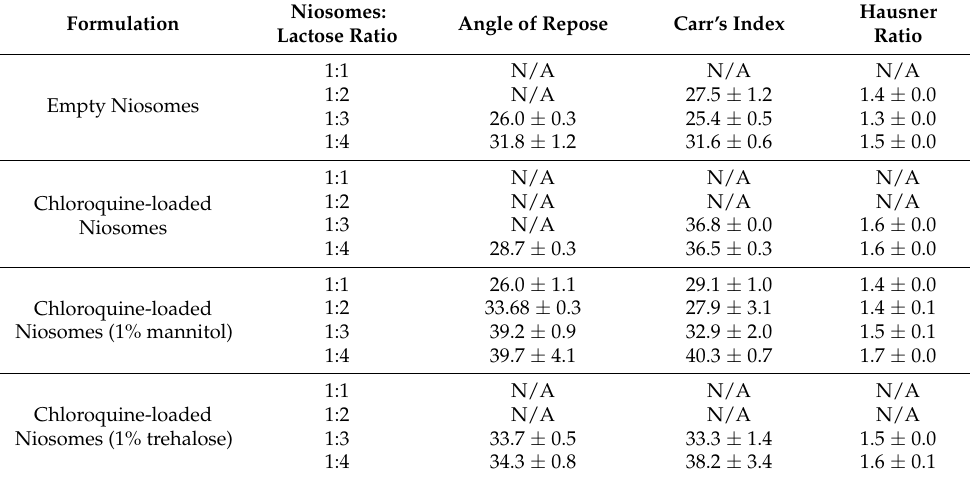
Table 2. Micromeritic properties of lyophilized empty niosomes and chloroquine-loaded niosomes mixed at various weight ratios with lactose (1:1–1:4), in terms of angle of repose, Carr’s index, and Hausner ratio. The effect of the presence of cryoprotectants, namely mannitol and trehalose, during the lyophilization process on the micromeritic properties was also studied. Values are presented as means ± SDs. Niosomes: Hausner Formulation Angle of Repose Carr’s Index Lactose Ratio Ratio Empty